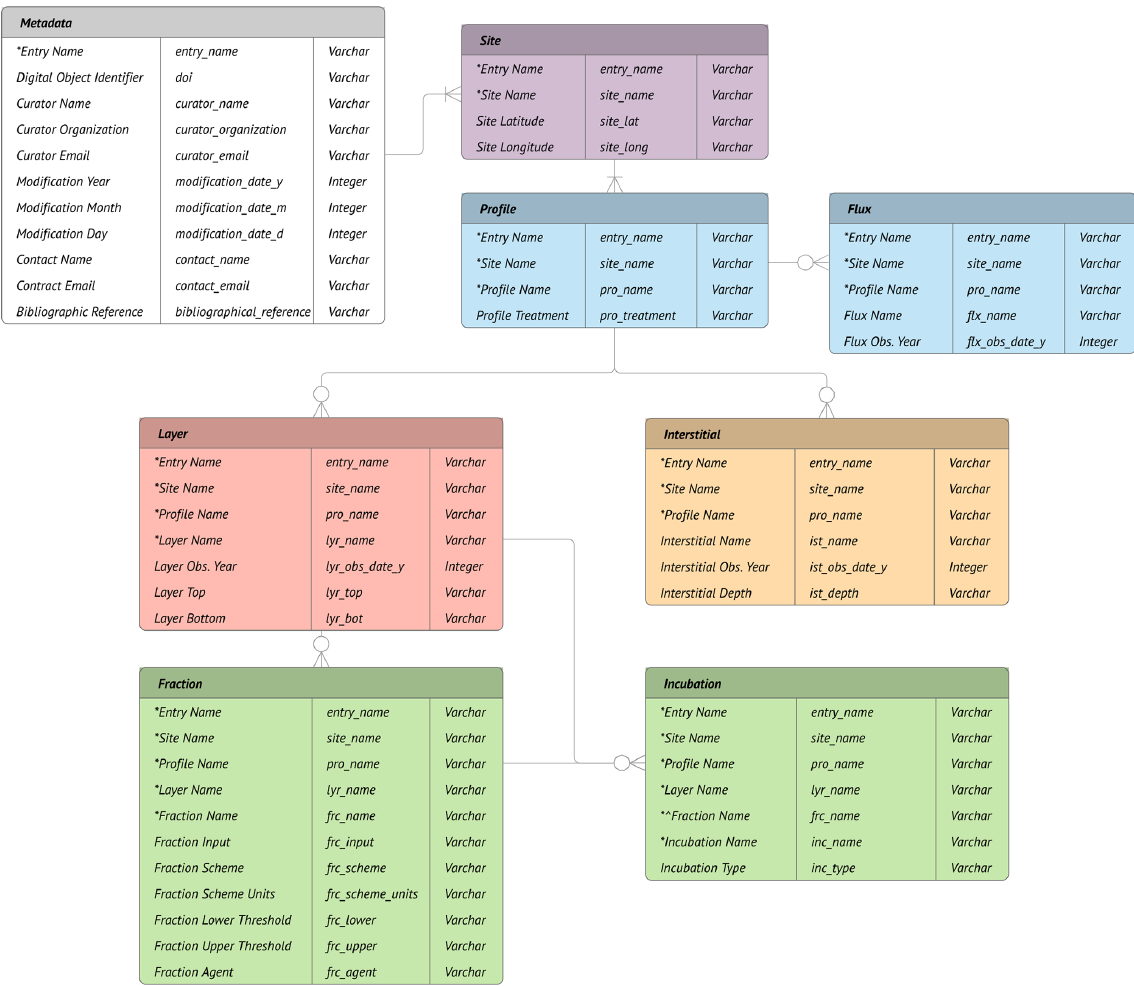
Figure 2. An entity relationship diagram for the International Soil Radiocarbon Database (ISRaD). A short description of the required variables for each entity is shown along with the field name used in the database and the variable data type. Crow’s foot connections with a straight line indicate mandatory daughter entities (one or more), whereas a crow’s foot with an open circle indicates optional (zero or more) daughter entities. The “*” indicates entries indicate keys, or linking variables, which are repeated at each successive level of the ISRaD hierarchy. The “ ∧ ” indicates conditionally required values. A full list of non-required variables is available in the template information